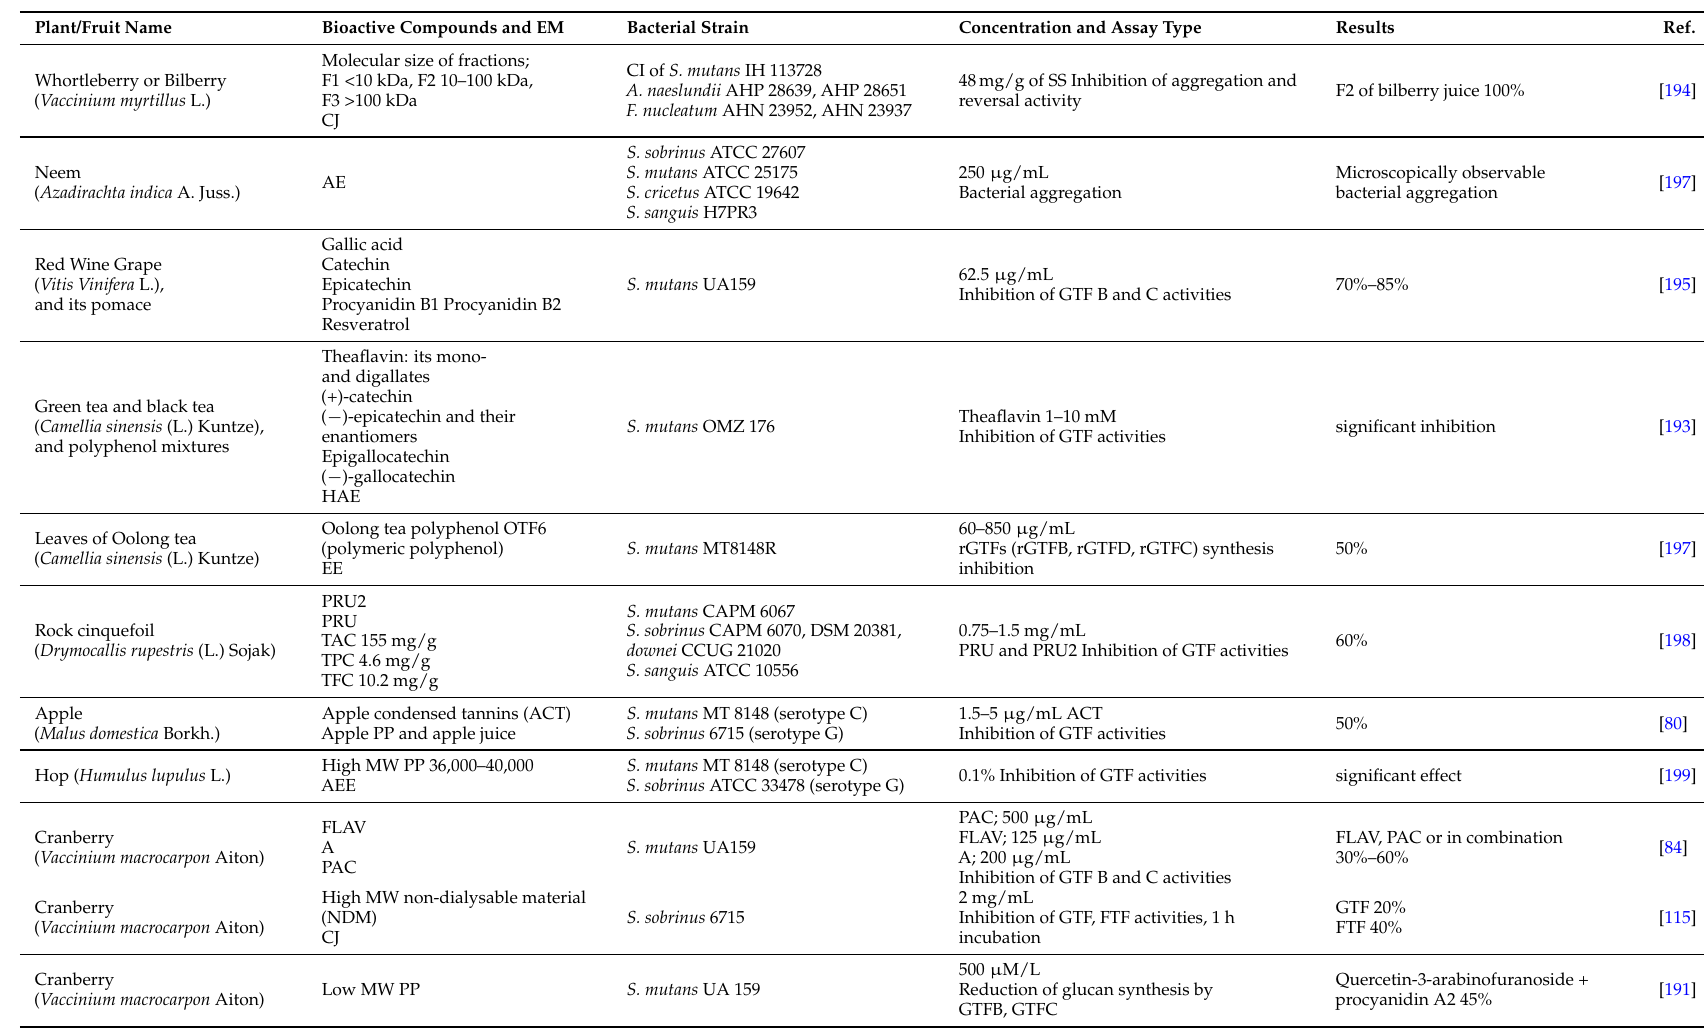
Table 7. Inhibitory effects of phytochemicals on glucosyltransferases, aggregation and quorum